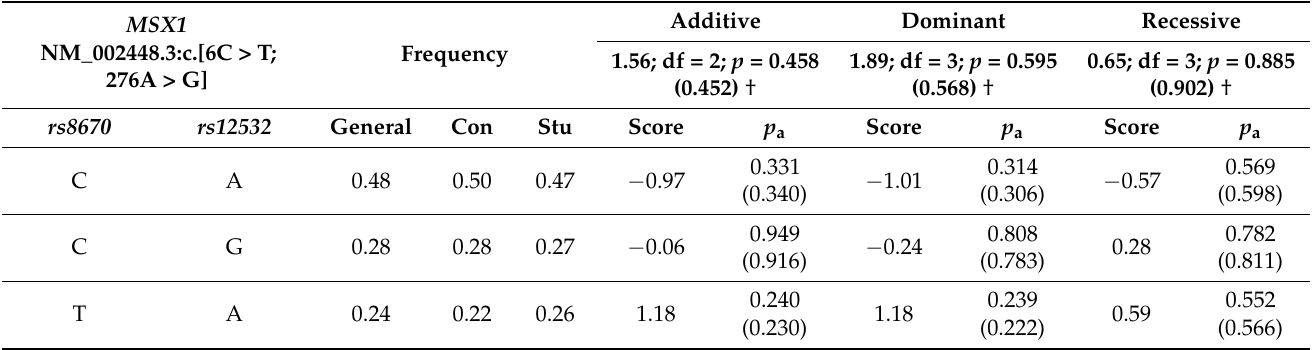
p a —values calculated for haplotype frequencies, comparisons between the control and study group, minimal haplotypes’ frequency taken into account during analyses—5%, p values corrected according to the sex are given in parentheses, score—magnitude and direction of effect, †—global significance